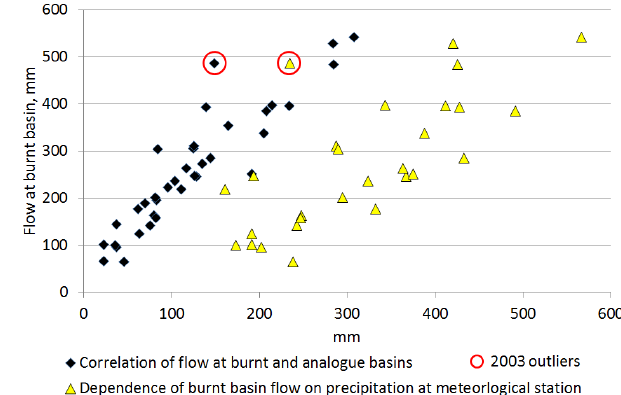
Figure 3. The dependence of summer (June–September) flow at burnt and analogue basins; the dependence of summer flow at burnt basin on summer sum of precipitation at nearest meteorological station during stationary conditions and the dependences outliers caused by fire. Here burnt basin: Vitimkan River at Ivanovsky (3109), analogue basin: Vitim River at Romanovka (3096) and me- teorological station – Karaftit. 1967–2004.